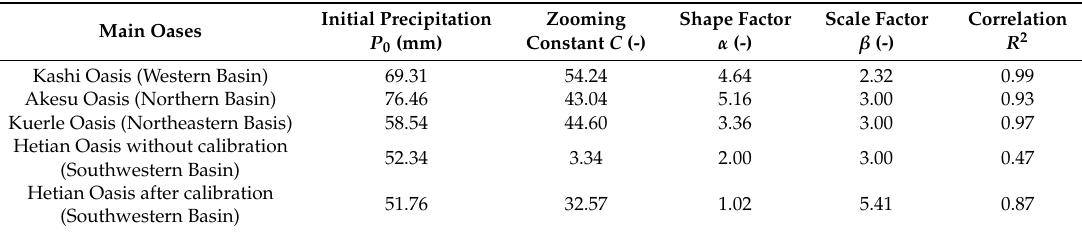
Table 1. Performance of the model and the parameters inversion for precipitation evolution from desert to oasis in different locations of the Tarim Basin.